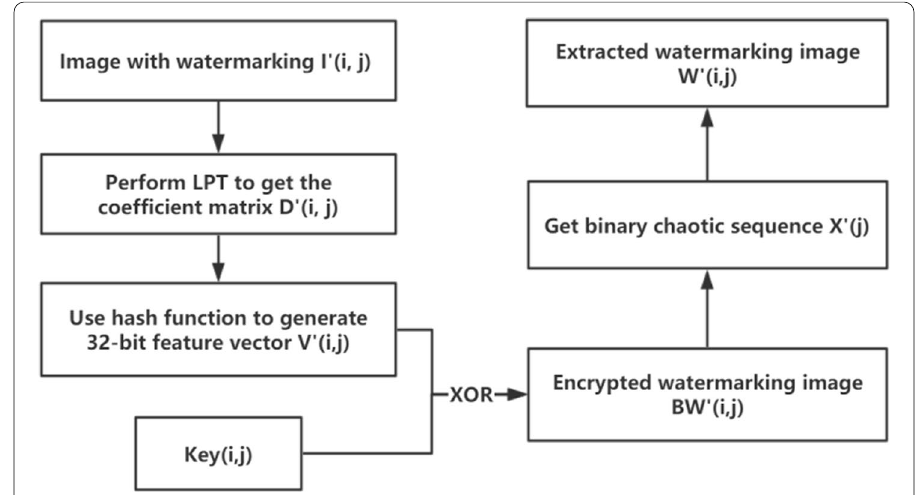
Fig. 4 Extraction diagram of